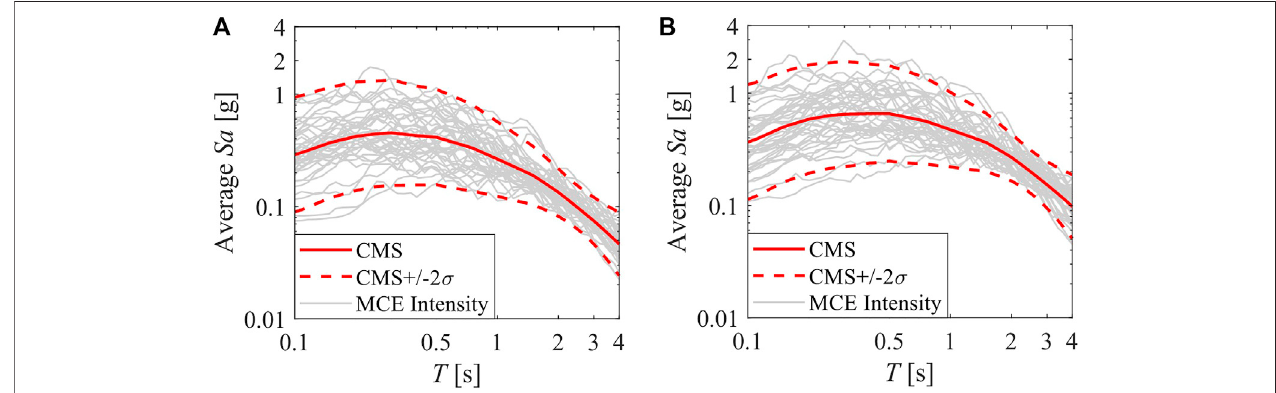
FIGURE 12 | Peak Δ s pro fi le for the prototype composite steel MRF at (A) DBE seismic intensity and (B) MCE seismic intensity.